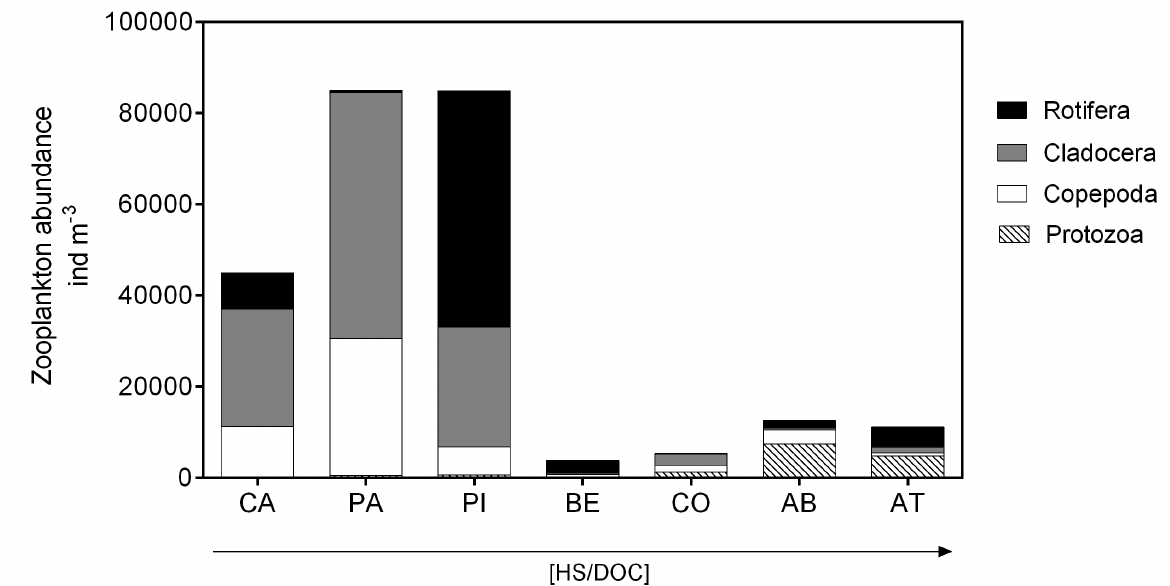
Figure 2. Zooplankton abundance (ind m -3 ) in all of the sampled environments along the studied HS gradient. CA= Cabiúnas; PA= Paulista; PI= Pitanga; BE= Bezerra; CO= Comprida; AB= Amarra-Boi; AT=